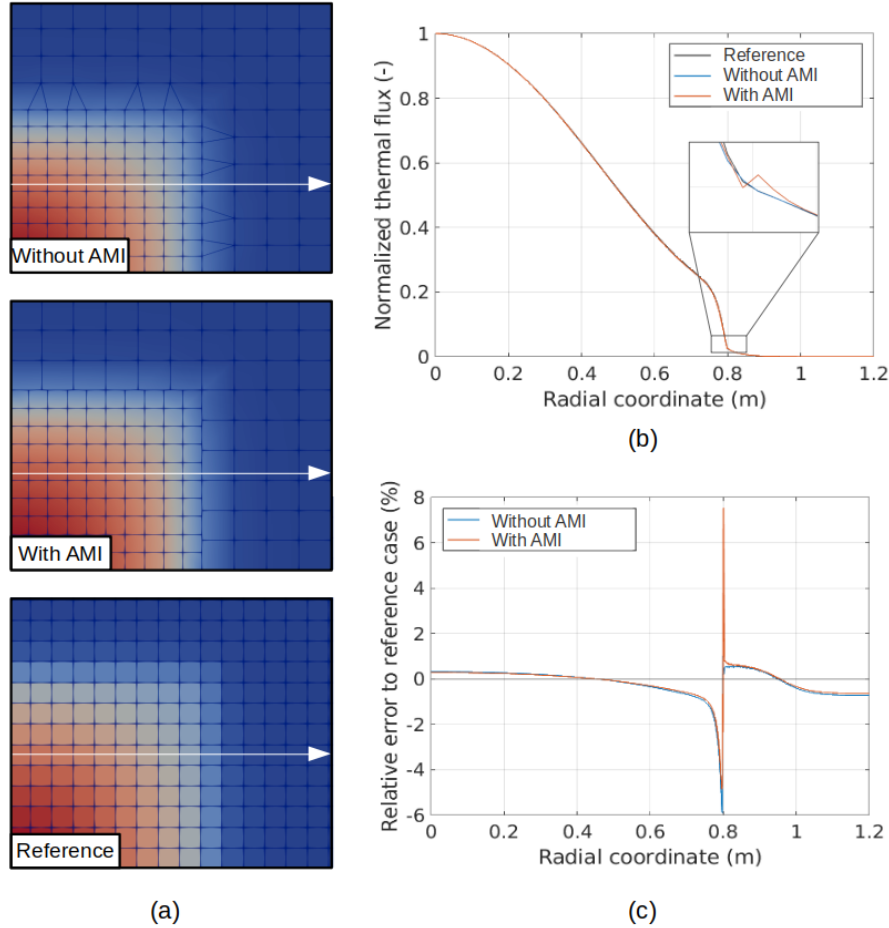
Figure 4. Arbitrary Mesh Interface (AMI) coupling condition study: ( a ) meshes used for the three test cases, ( b ) thermal neutron flux traverses, and ( c ) their relative error to the reference